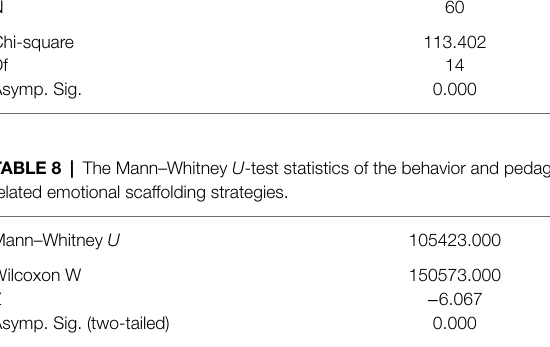
TABLE 7 | Friedman test statistics of the behavior-related emotional scaffolding strategies in the teachers’ views.